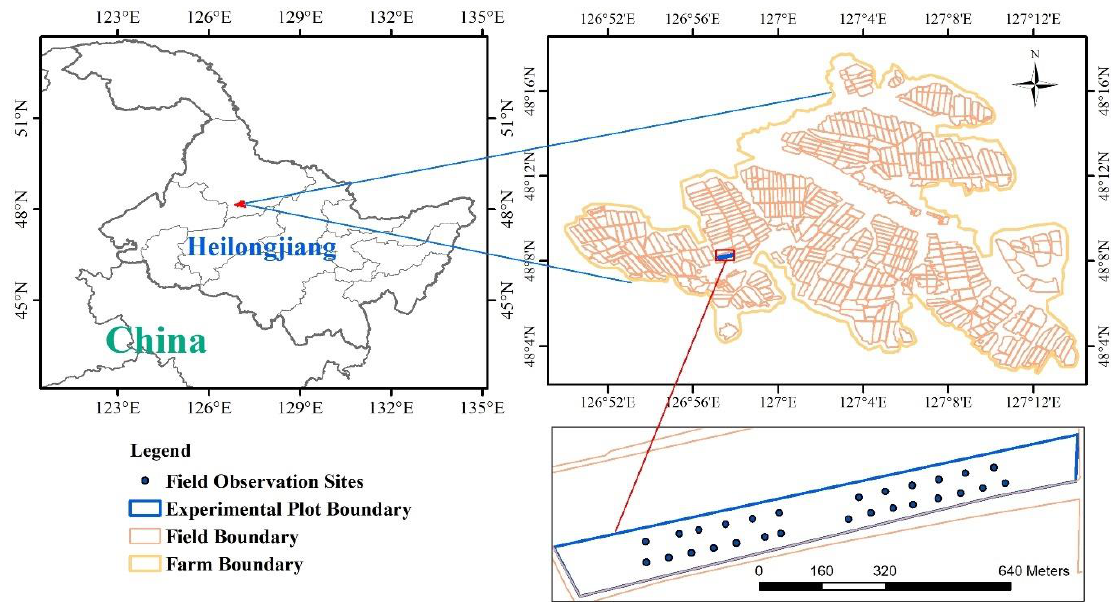
Figure 1. Locations of the study area and the field observation sites.